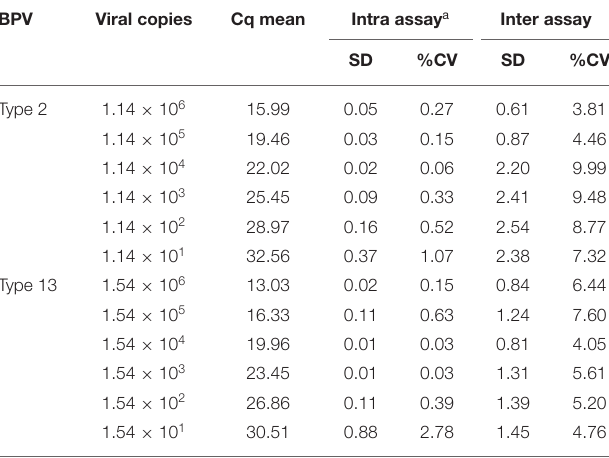
TABLE 2 | Intra- and interassay variability of SYBR Green qPCR for BPV2 and 13 E6 gene detection.